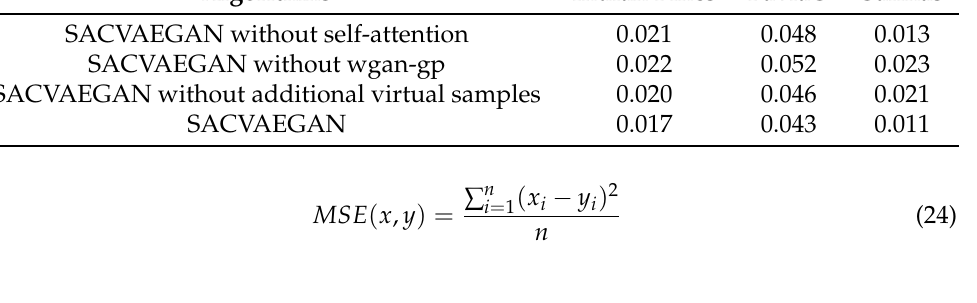
Figure 10. Illustration of the spatial features on the Indian Pines ( a – e ), PaviaU ( f – j ), and Salinas ( k – o ) data sets. Table 13. MSE when self-attention, WGAN-GP, and additional virtual samples are removed.